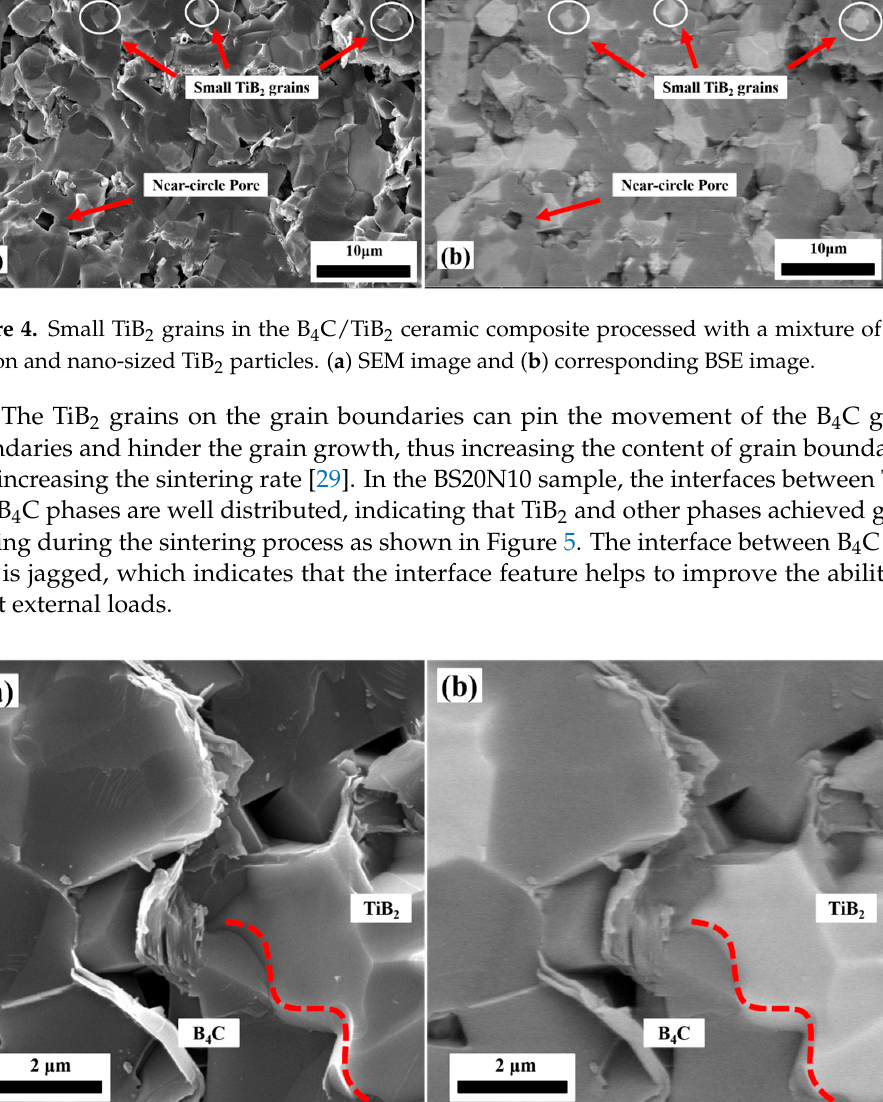
Figure 3. Fracture morphology SEM images of the B 4 C/TiB 2 ceramic composites with various TiB 2